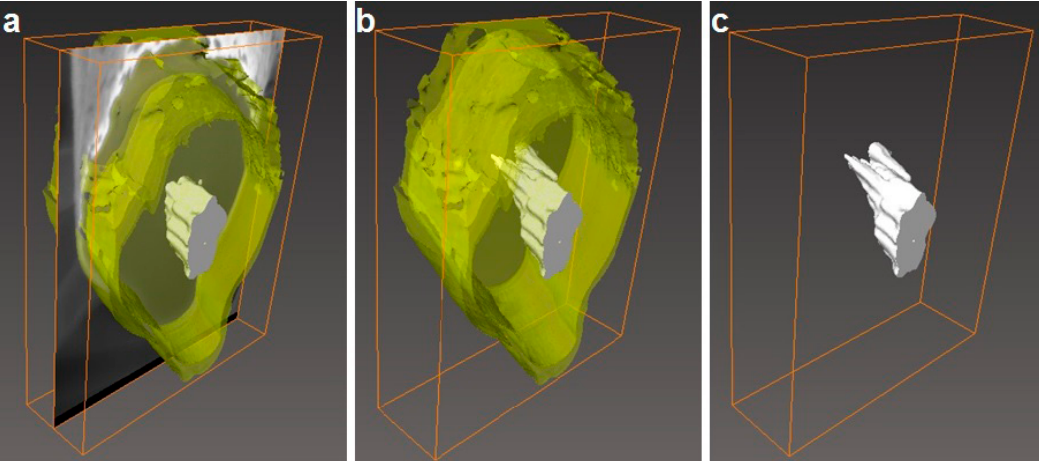
Figure 9. ( a ) The side view of the 3D reconstruction of the PHB fiber (in semi-transparent yellow) and Pd nanoparticles (in white), including the SEM image (obtained from FIB sectioning) in the middle of the reconstruction, ( b ) 3D reconstruction of the PHB fiber with Pd nanoparticles inside ( c ) 3D reconstruction of particles only from the inside of PHB fiber 2. The binding box size for this reconstruction had the following dimensions: 1.996 × 2.464 x 0.612 nm.